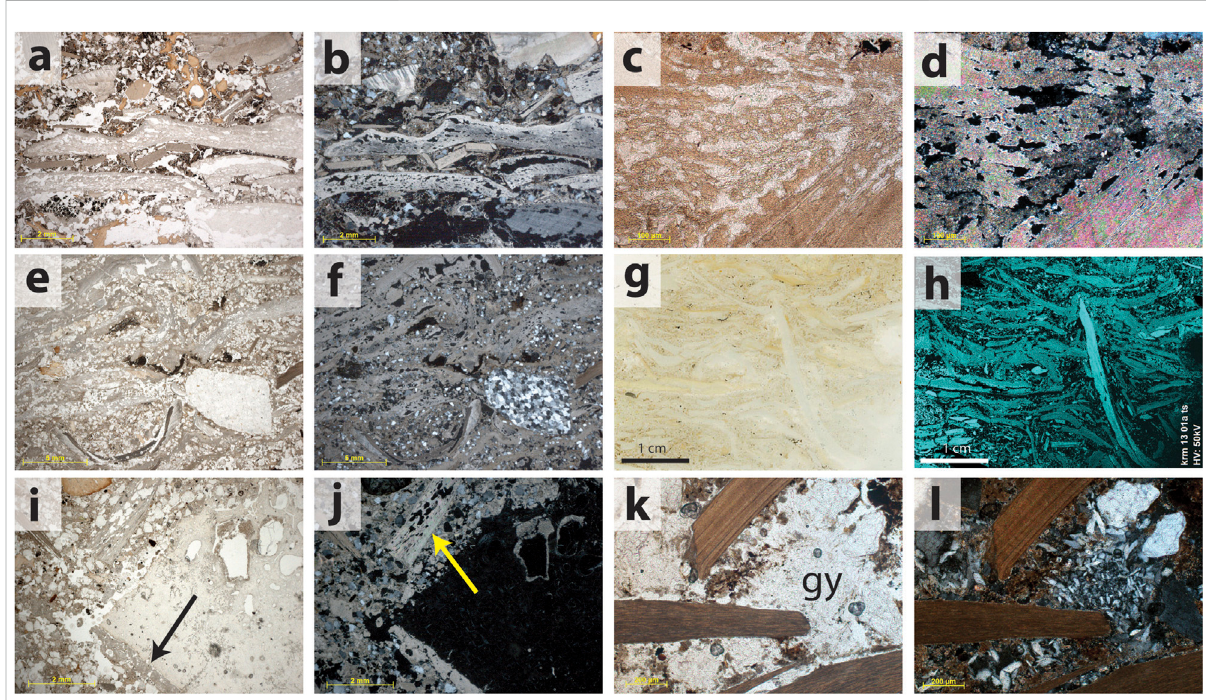
FIGURE 4 The dominant taphonomic processes impacting shell in the MSA deposits of Cave 1. (A) This sample from the Witness Baulk contains at least 8 discreteshells,illustratingarangeofinternalporosityduetodecalci fi cation,aswellasfragmentationanddeformationinplace.PPL. (B) Sameviewas (A) ,XPL. (C) Highmagni fi cationdetailofashellcomposedofaragonitethathasinternalporosityduetodecalci fi cation.PPL. (D) Sameviewas (C) XPL. (E) SamplefromtheMSAIdepositslocatedatthepointofconnectionbetweenCave1andCave1a(KRM-13-01).Althoughdif fi culttoseedueto thecalcareousmatrix,over50%oftheimageiscomposedofhorizontallyorientedshell.PPL. (F) Sameviewas (E) ,XPL. (G) Incidentlightscanofathin section from sample KRM-13-01. (H) An elemental distribution map of calcium produced from the same area as (G) . Here, the shells and their abundanceareeasier to seecomparedtothephotomicrographs, andtheshells composed ofaragoniteexhibitalowerCaabundancerelativetothe shells composed of calcite. One particular shell composed of calcite is oriented vertically, and the shells composed of aragonite are deformed over its pointed edge. (I) A fragment of bone from sample KRM-13-02 exhibits a pendant of secondary calcite (arrow). PPL. (J) Same view as (I) , XPL. The arrow indicates a porous shell fragment. (K) Three relatively well-preserved shell fragments from the base of the Witness Baulk have a nodule of secondary gypsum (gy) in between them. PPL. (L) Same view as (K) ,